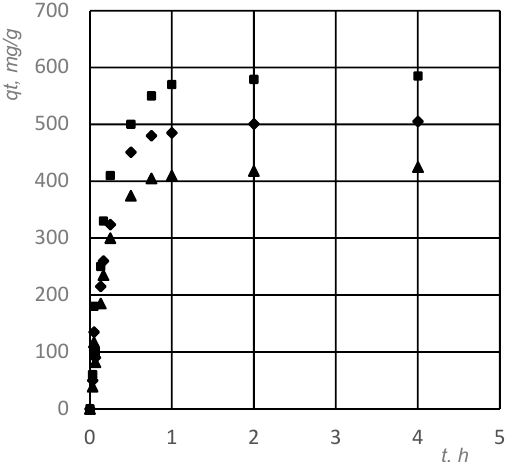
Figure 6. The influence of contact time on diazepam concentration uptake by mineral clay, for dif- ferent initial concentrations; T = 37.0 ± 0.1 °C; pH = 6.80 ± 0.05; ■ C i = 18 mg/L; ◆ C i = 12 mg/L; ▲ C i = 6 mg/L; and S:L ratio = 1 g/L.